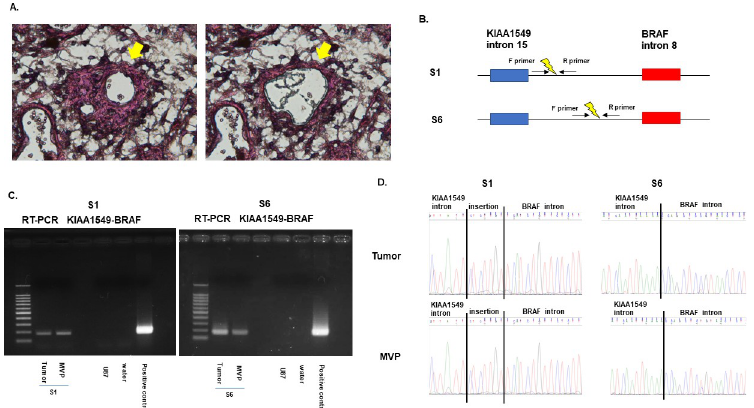
Fig 3. Evaluation of the KIAA-BRAF fusion gene in cellular components of MVP by genomic PCR. (A) Cellular components of MVP were collected from FFPE slides with laser microdissection (arrows). (B) Special primers designed for around breakpoints. (C) PCR analysis with the special primers was performed for fusion gene detection. Samples S1 and S6 exhibited a positive band for tumor and for cellular components of MVP. (D) Sanger sequencing was performed to confirm the amplified products. In S1 and S6, tumor cells and cellular components of MVP exhibited the same base sequence, including breakpoints.